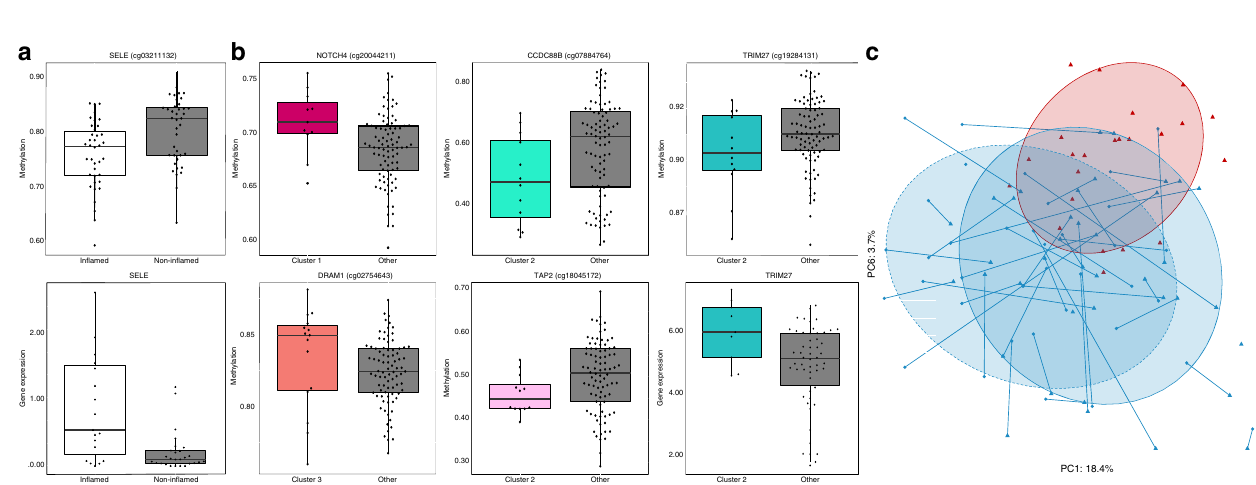
Fig. 4 Differences in host DNA methylation and gene expression across subject groups with regards to in fl ammation and microbiota clustering. Signi fi cant differential host DNA methylation [beta values; signi fi cance determined using mixed linear models from lme4 library, adjusted with FDR] with corresponding gene expression [log2(fragments per kilobase of transcript per million mapped reads)] of examples of immune-related genes in a in fl amed/ non-in fl amed CD tissue, b microbiota clusters 1 – 3 (expression, using stattest from the ballgown library, was signi fi cant before adjustment for multiple testing with FDR, and for a subset of 71 matching samples; extreme outliers removed to improve clarity; gene body methylation in NOTCH4, DRAM1, and TRIM27 ( b ), promoter methylation in SELE ( a ) and CCDC88B ( b )) (box plot lower and upper sides show 25th and 75th percentiles, respectively. The whiskers are 1.5 of the interquartile range). c Epigenome principal component analysis outlining the in fl ammation- (PC1) and disease- (PC6) associated epigenetic